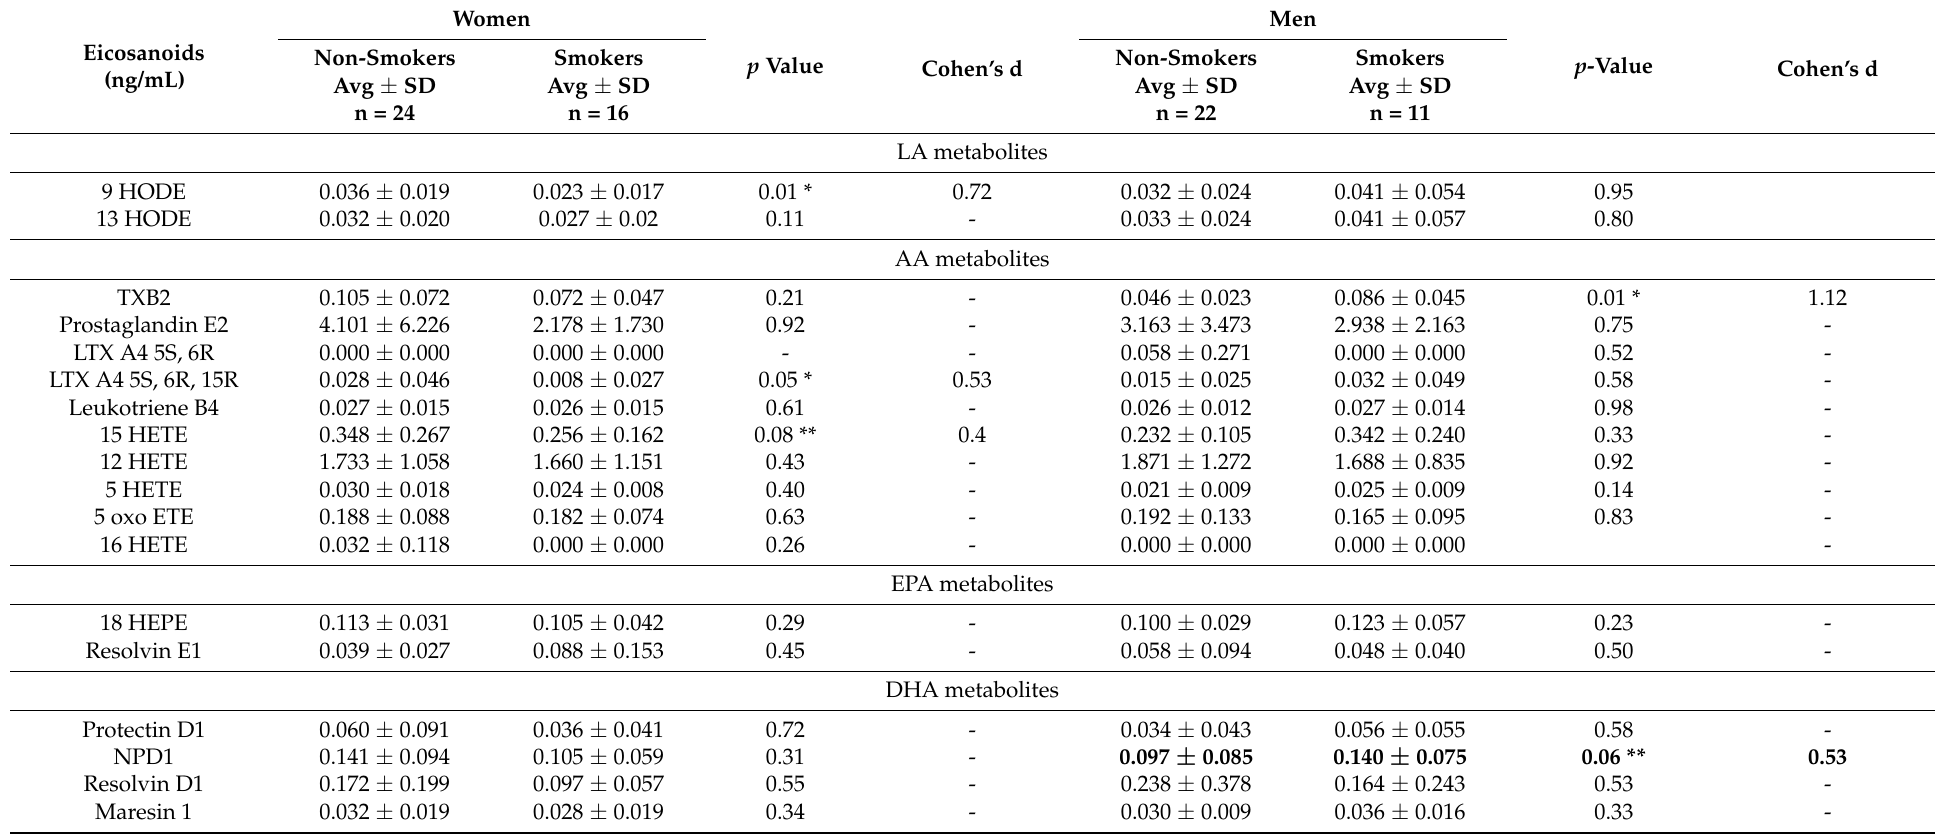
Table 2. Eicosanoid levels in smokers and non-smokers, including